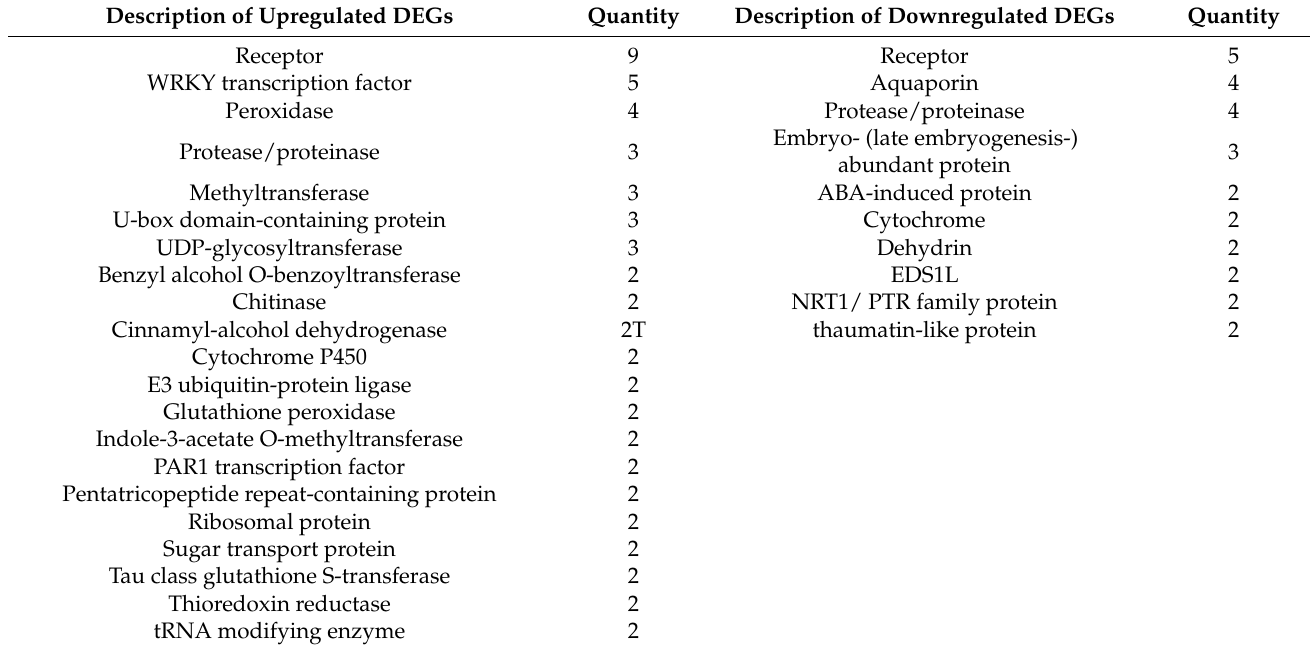
Table 9. Comparison of most frequent simplified DEG descriptions between inoculation-specific up- and downregulated transcriptome segments (total number of upregulated DEGs = 143, downregulated DEGs = 75). Description of Upregulated